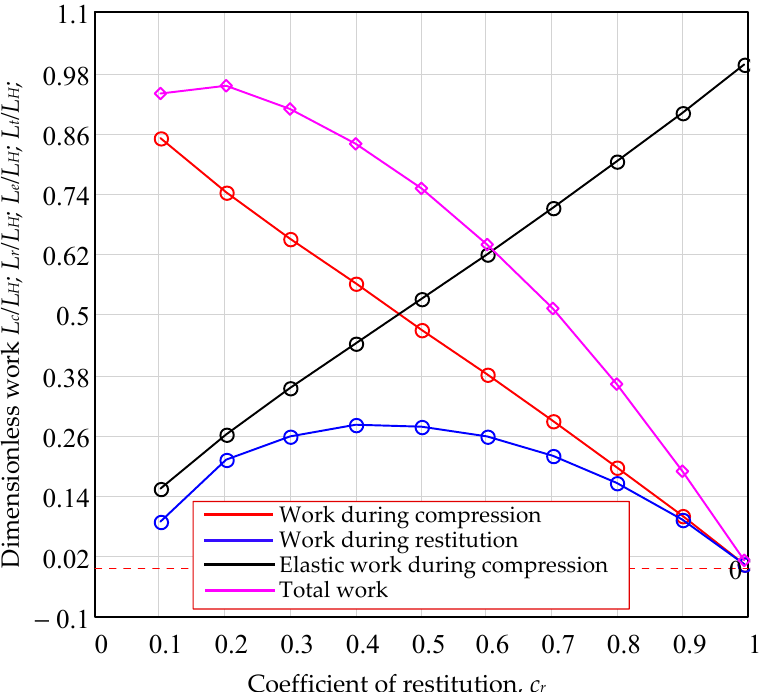
Figure 31. Dependency of L C —work done during the compression phase, L r —work done during the restitution phase, L e —work of elastic force during the compression phase and L t —total work, on coefficient of restitution, c r .